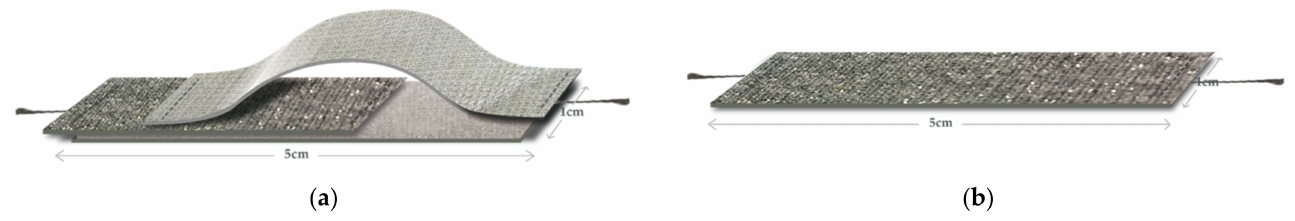
Figure 2. Two types of fabric sensors used in our prototype: ( a ) Neck flexion/extension fabric sensor, made of two kinds of conductive fabrics; ( b ) Arm, elbow, and shoulder movements’ fabric sensor, made of conductive knitted elastic